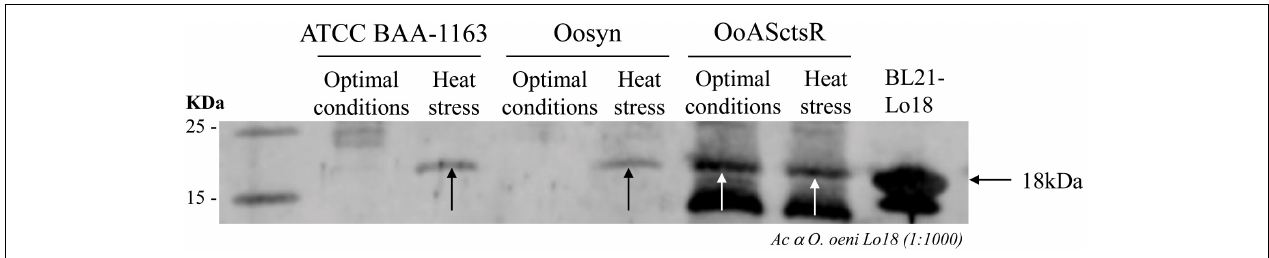
FIGURE 1 | Immunodetection of Lo18 in O. oeni wild type strain (ATCC BAA-1163) and recombinant strains carrying the control pSIPSYN plasmid (Oosyn) or pSIPSYNASctsR plasmid allowing expression of asRNA targeting ctsR (OoASctsR) were cultivated at 28 ◦ C in FT80m medium up to the end of the exponential growth phase. Total cellular proteins were extracted immediately (28 ◦ C) or following a sub-lethal thermal treatment (30 min at 42 ◦ C). For each strain and each condition, 15 µ g of protein were separated by SDS-PAGE. The O. oeni Lo18 protein was detected by immunodetection with polyclonal antibodies directed against Lo18 and anti-rabbit antibodies conjugated with IRDye 680LT fluorophore (LiCor R (cid:13) ) as secondary antibody. Total protein extract from E. coli BL21 λ DE3 carrying pET hsp18 plasmid was used as a positive control (BL21-Lo18).